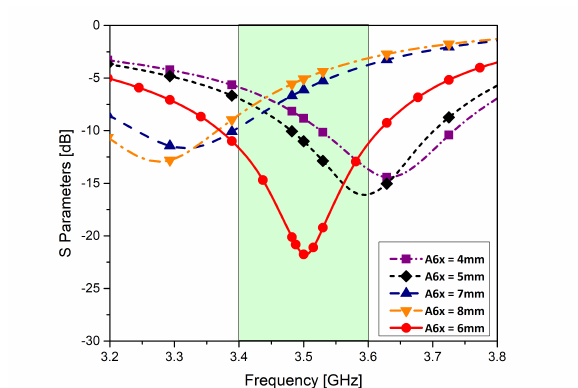
Figure 2. Return loss of different antenna designs.